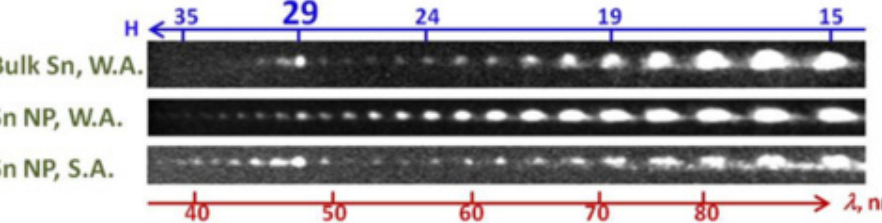
Figure 4. Raw images of harmonic spectra in the case of 1370 nm and 685 nm pumps of tin-containing plasmas. Upper panel: Plasma produced on the tin bulk target at the fluence F = 1.4 J cm − 2 . Middle panel: Plasma produced on the Sn nanoparticle (NP) target at the fluence F = 1.4 J cm − 2 . Bottom panel: Plasma produced on the Sn NP target at the fluence F = 2 J cm − 2 . “W.A.” and “S.A.” correspond to weak and strong ablation of the Sn-containing target.